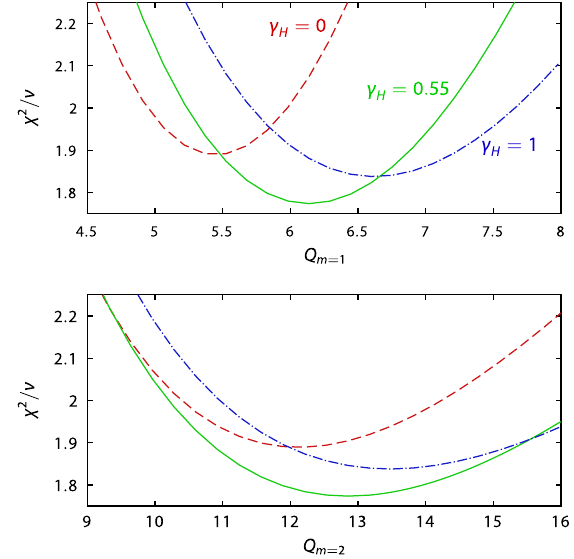
_ R=R “ Hubble friction ” FIG. 7. Goodness of fit χ 2 = ν , where ν is the number of degrees of freedom, versus quality factors for the m ¼ 1 , 2 modes for various values of γ H